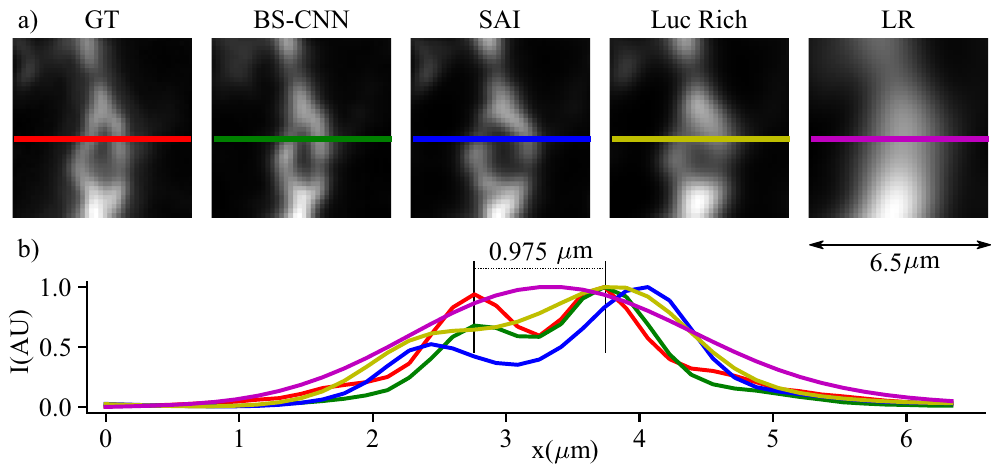
Figure 4. Performance on experimental measurements: the output of the BS-CNN averaged over 600 low- resolution frames for mouse neurons prepared with Alexa Fluor 533 fluorophores along with the line profiles and comparison with the standard SAI and Lucy Richardson deconvolution. The field of view is 6.50 µ m. The low resolution image has a resolution of 2.37 µ m. BS-CNN achieves an image resolution of 0.975 µ